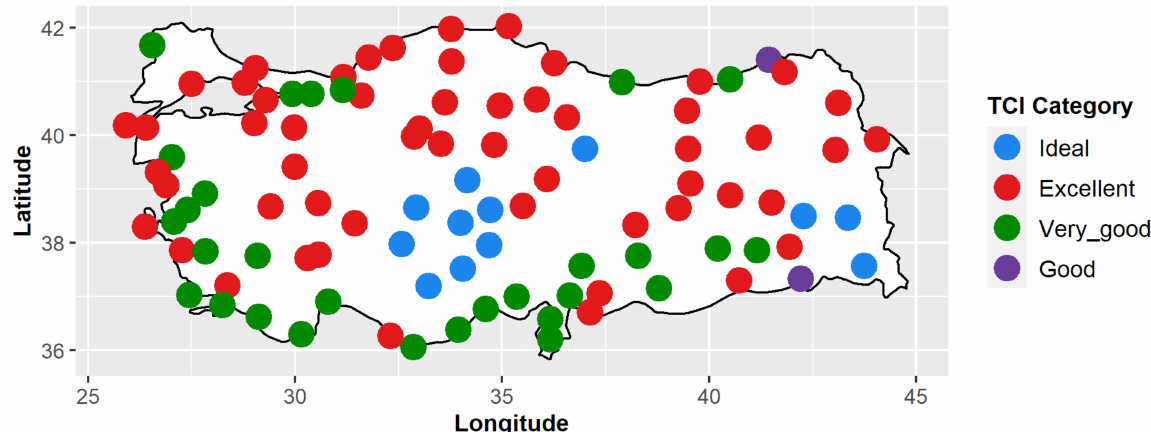
Figure A6. TCI distribution for May.